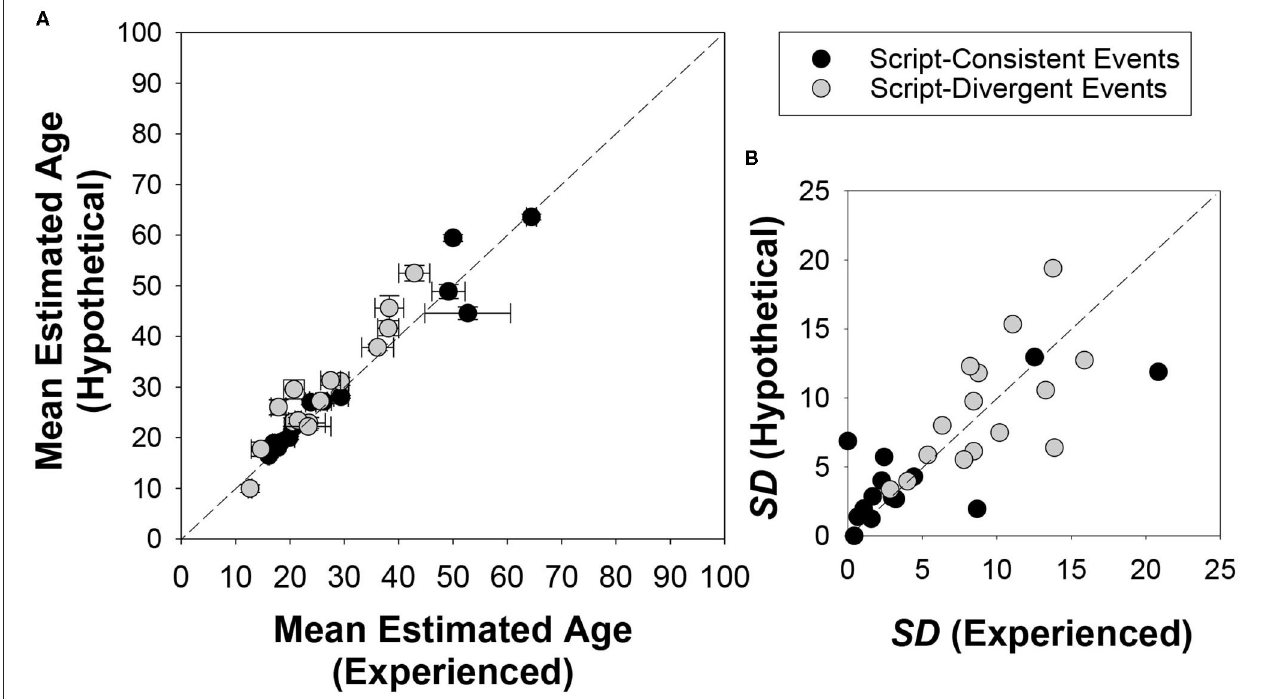
FIGURE 3 | Mean (A) and SD (B) of the estimated age of an average canadian at the occurrence of the events produced by participants in the experienced and hypothetical conditions. Error bars indicate ± 1 standard error of mean. The event, “begin grade school,” is omitted in both graphs because it only has estimates from the experienced condition ( M = 5.68, SD = 1.39, SE =